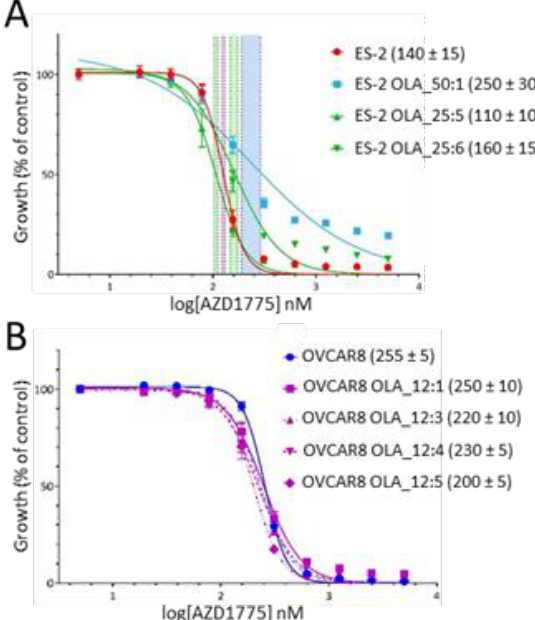
Figure 5. Sensitivity of olaparib-resistant HGSOC clones to WEE1 inhibition. ( A ) Olaparib resistant ES-2 clones remain largely sensitive to AZD1775. AZD1775 growth curves for three independent ES-2 clones resistant to 25 µ M (green) or 50 µ M olaparib (blue) are shown. ES-2 parent curve is in red. AZD1775 IC50 values for each curve (in nM ± SEM) are shown in brackets. 95% confidence intervals for IC50 values are shown as colored vertical bars. ( B ) Olaparib resistant OVCAR8 clones remain sensitive to AZD1775. AZD1775 growth curves for four OVCAR8 clones resistant to 12 µ M olaparib (pink) are shown. OVCAR8 parent curve is in blue. AZD1775 IC50 values for each curve (in nM ± SEM) are shown in brackets. All olaparib-resistant clones show the same sensitivity to AZD1775 as the OVCAR8 parent.